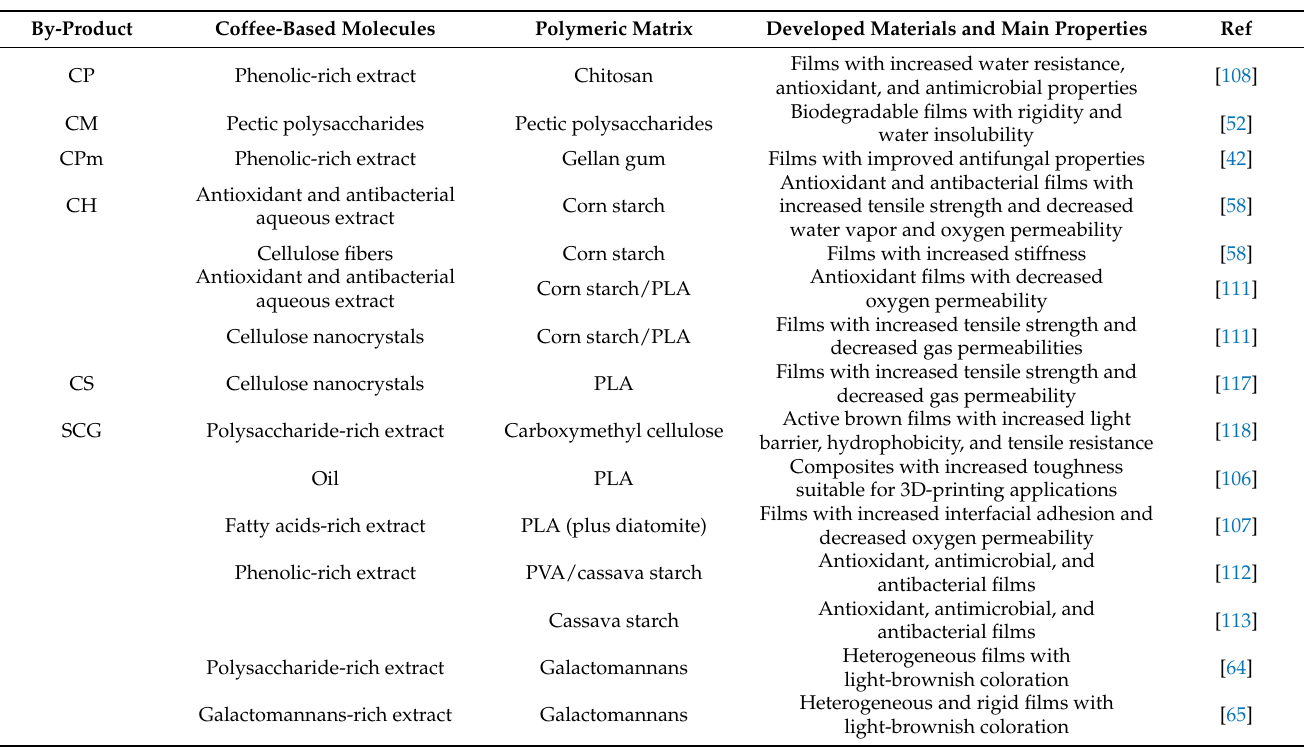
Table 4. Coffee by-products used as a source of extracts with film-forming ability or with functional properties for biodegradable materials